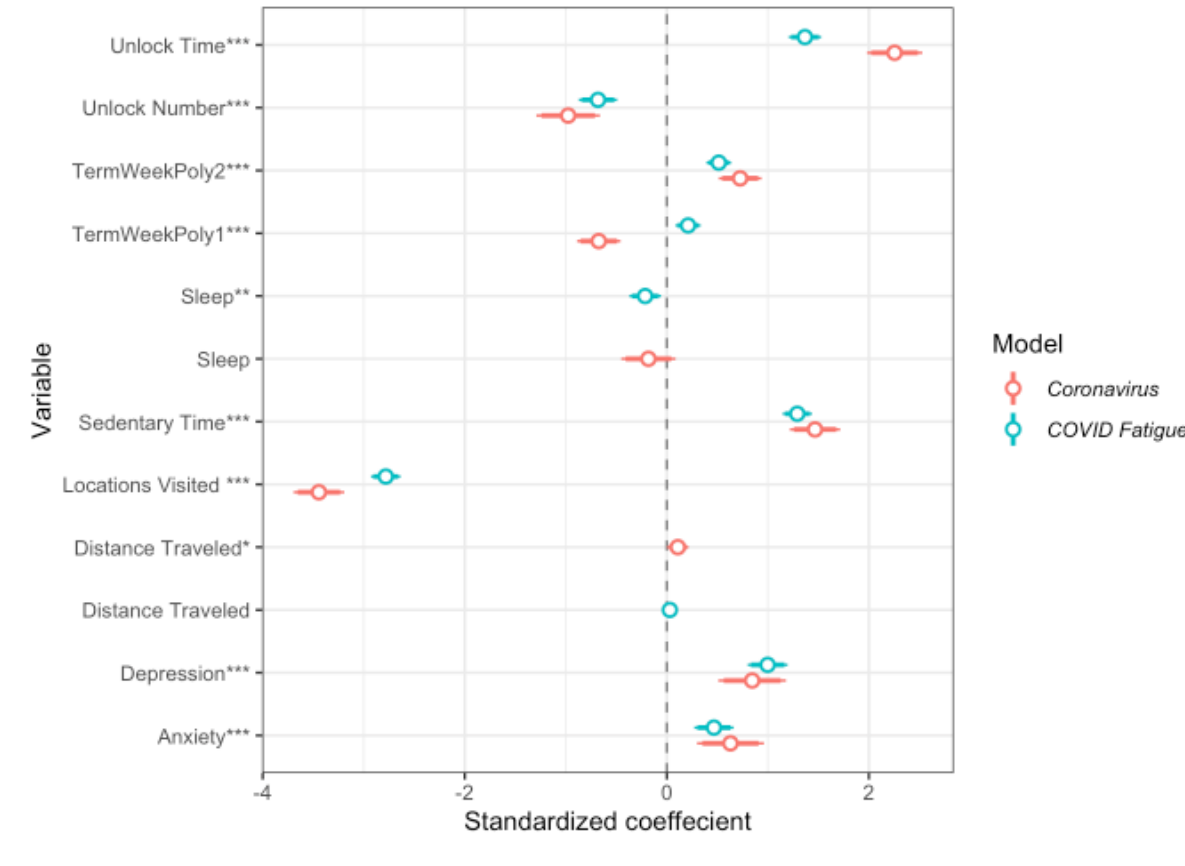
Figure 4. Coefficient plots from mixed linear models of interest in the search terms coronavirus and COVID fatigue , inferred by mobile